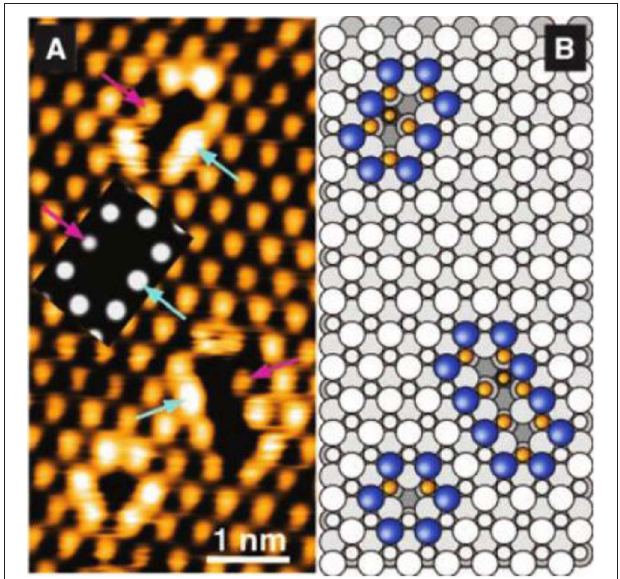
FIGURE 4 | Dimerization of the oxygen vacancies in the CeO 2 facet (111) (A) STM image (B) Corresponding structural model (Adapted from Esch et al., 2005